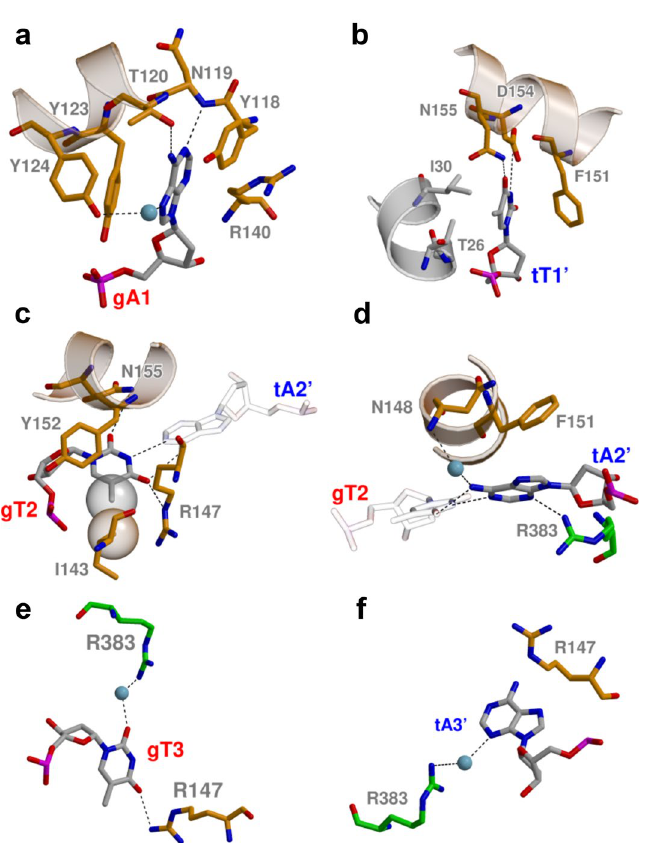
Figure 5. AfAgo interaction with the first three base pairs of the 5 ′ -ATT DNA duplex. gA1 ( a ) and tT1‘ ( b ) in their respective pockets. ( c , d ) Recognition of gT2 and tA2’ of the second base pair. ( e , f ) Interactions with gT3 and tA3’ of the third base